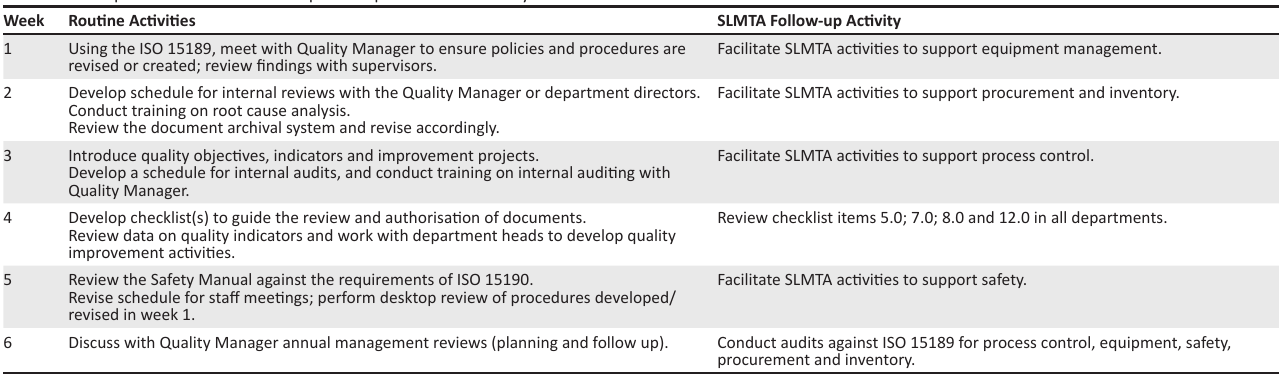
TABLE 3: Example of six-week mentorship action plan for a